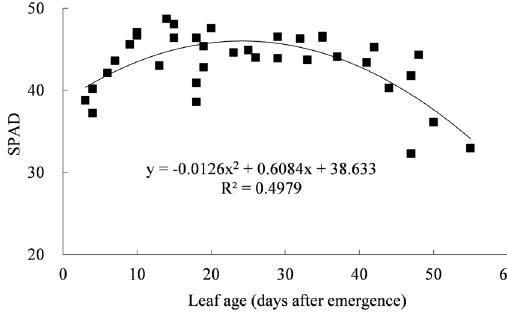
Figure 1. Rice leaf SPAD varied along with leaf aging.